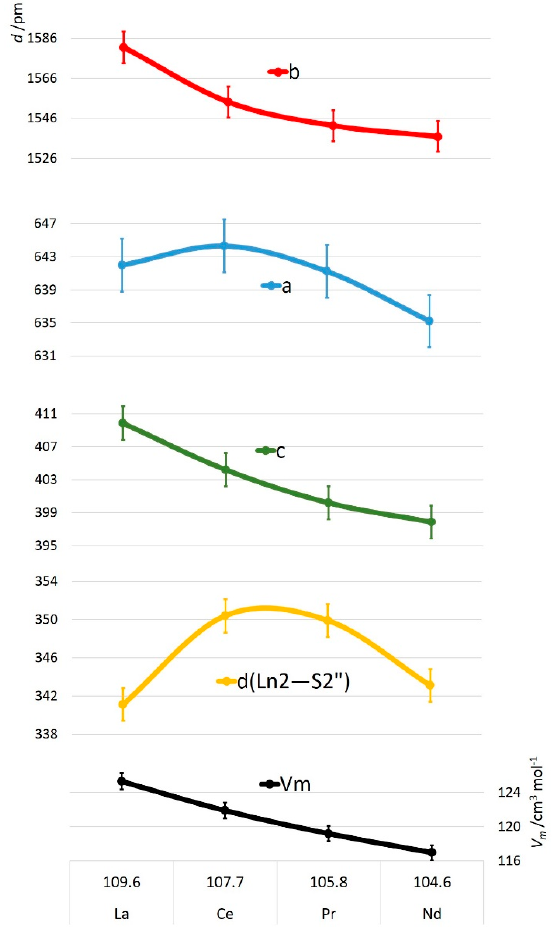
Figure 2. Lattice parameters ( a , b , and c ), selected distances ( d ( Ln 2–S ″ )), and molar volumes ( V m ) of the complete A-type Ln 4 N 2 S 3 series ( Ln = La–Nd, error bars with a percentage of 0.5%) versus the ionic radii ( r i ) of the trivalent lanthanide cations [17].